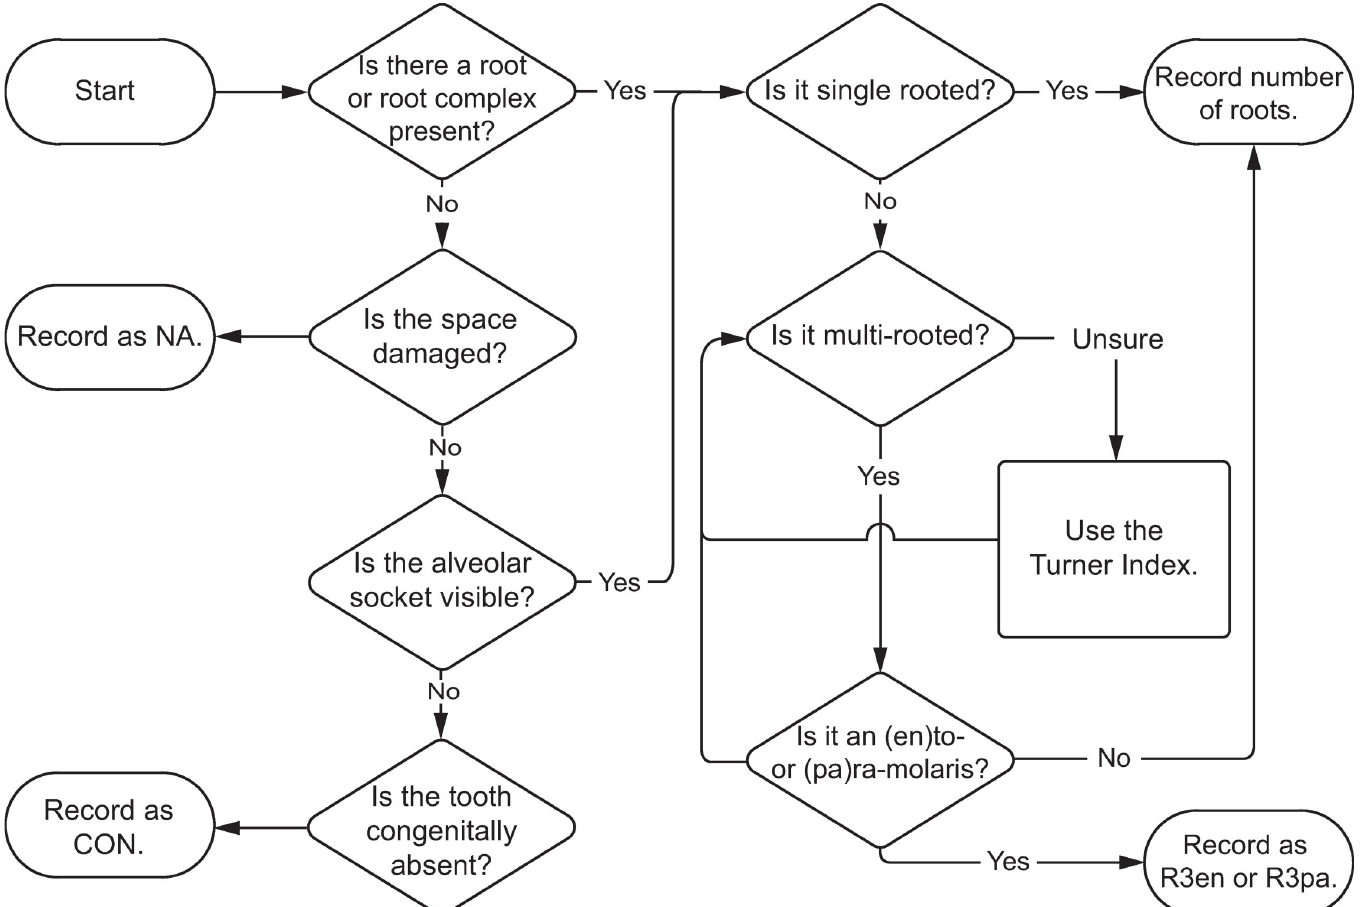
Fig 13. Flow chart for determining and recording phenotype element 1—root number or absence.